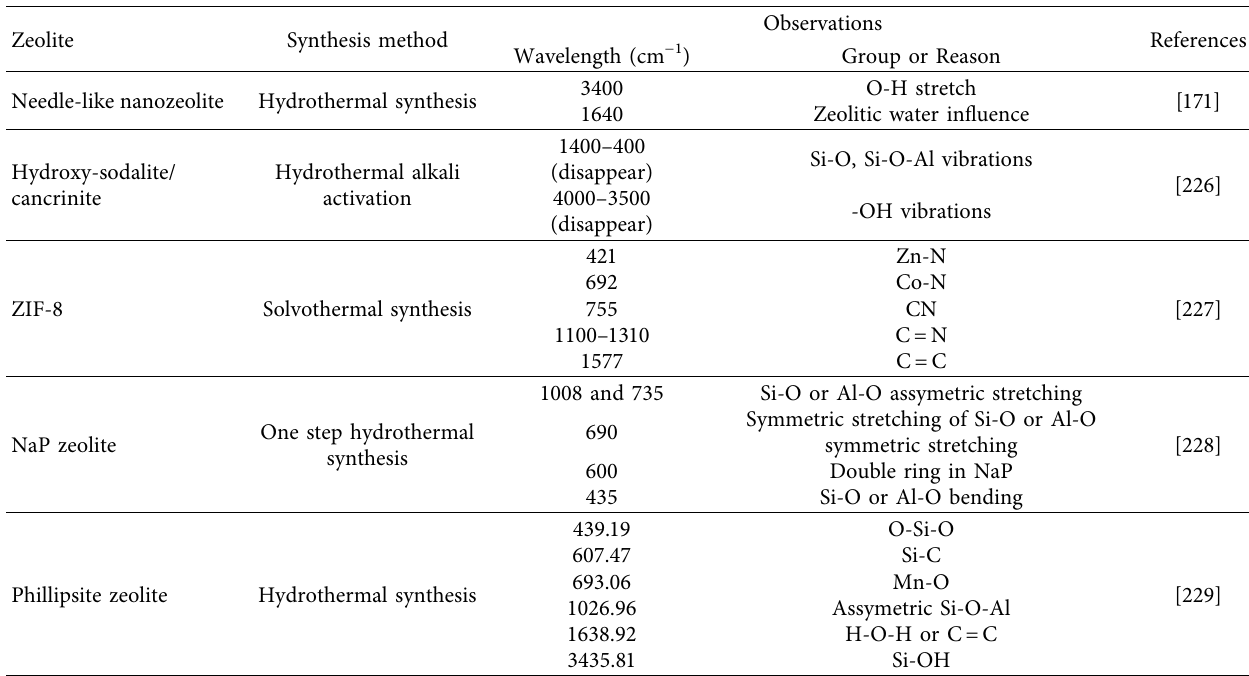
Table 7: Summary of FTIR analysis of